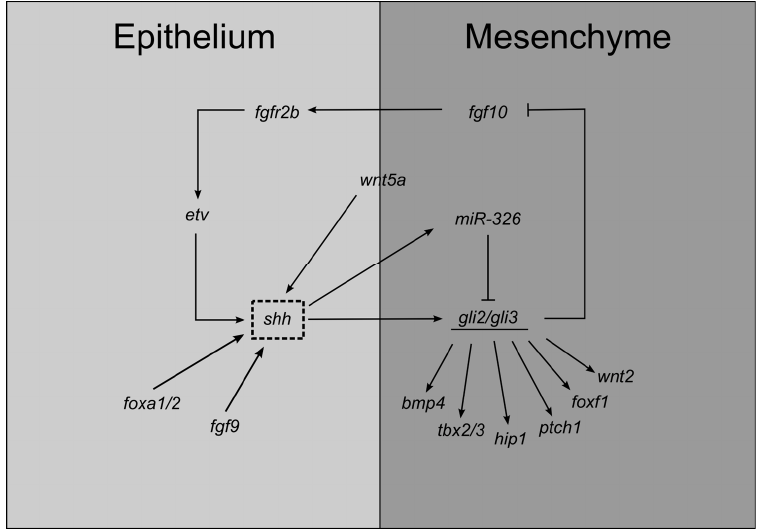
Figure 3. Schematic representation of SHH main interactions during lung endoderm specification.